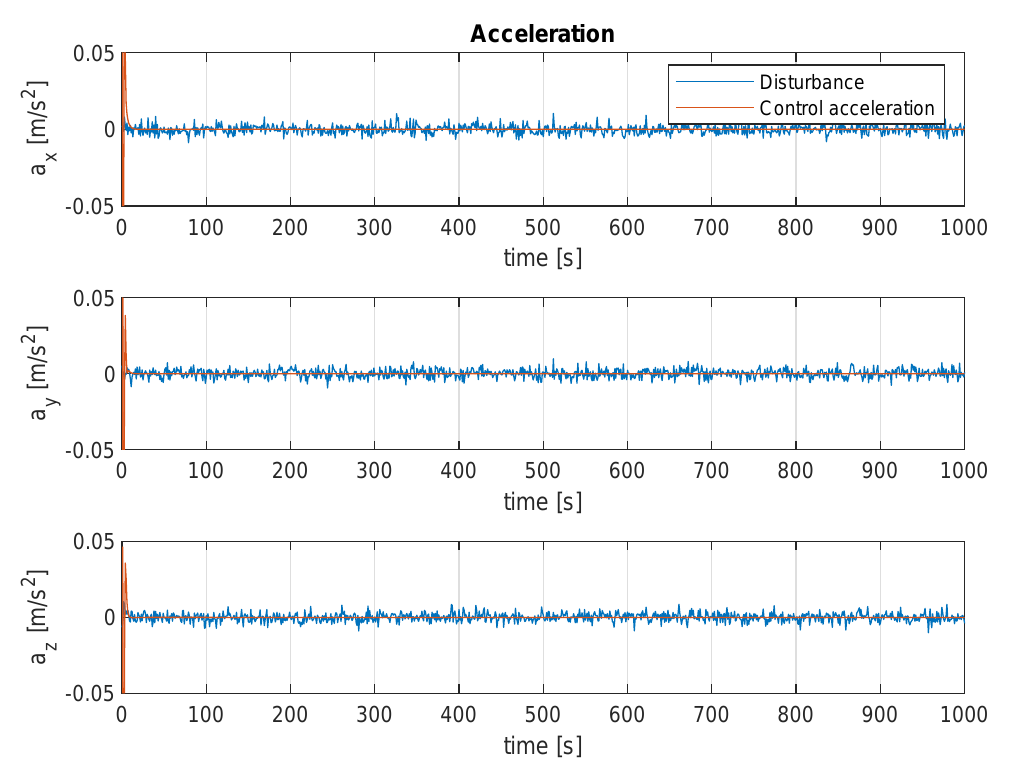
Figure 16. Accelerations acting on satellite 1 during simulation time, namely disturbance and control